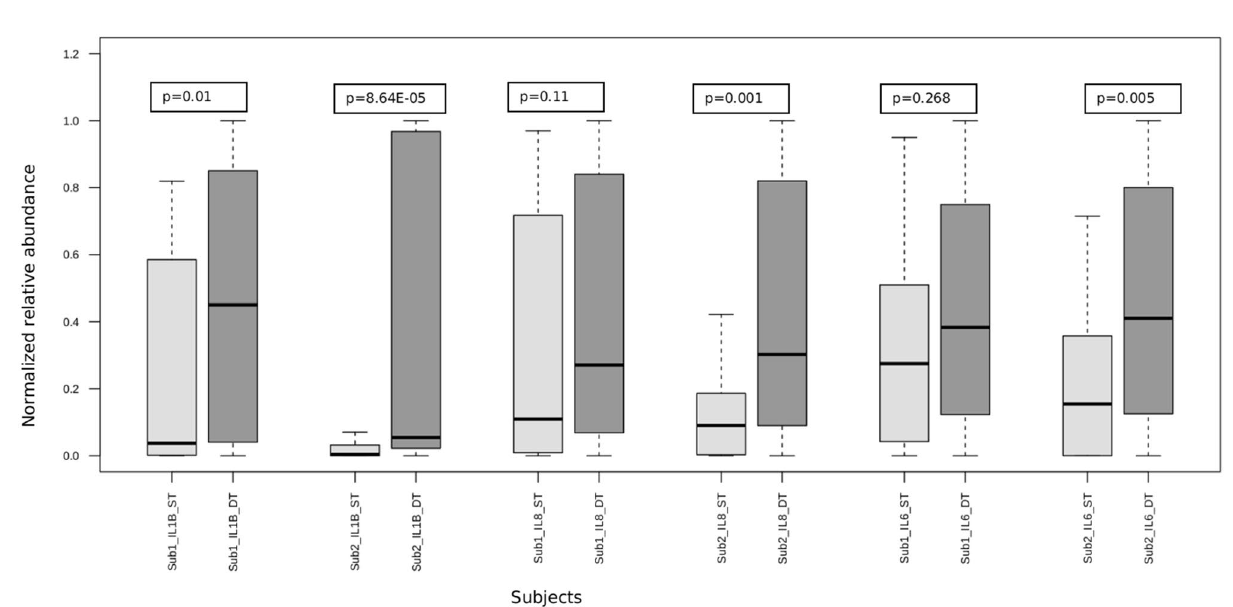
Figure 8. Differences in the normalized cytokine levels at same and different time points for 2 subjects over 3 days. Here, three cytokines were studied, IL1β, IL-8 and IL-6. Each boxplot represents a subject’s cytokine level at same (ST) or different (DT) time points. Mann–Whitney test was used to determine if the values across the groups (ST and DT) differ and the corresponding p-value obtained have been written on the top of each plot. All the differences were statistically significant except at Subject 1 IL-8 and